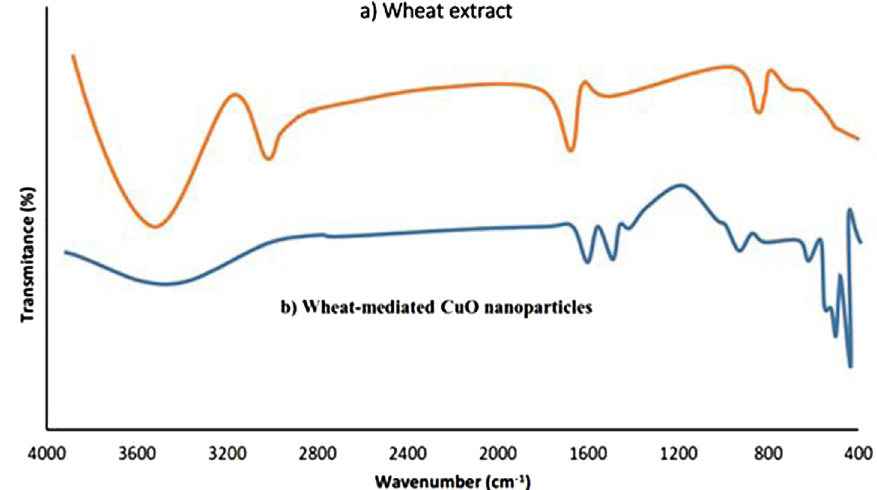
Figure 2: (a) FTIR spectra of wheat extract and (b) wheat-mediated CuO